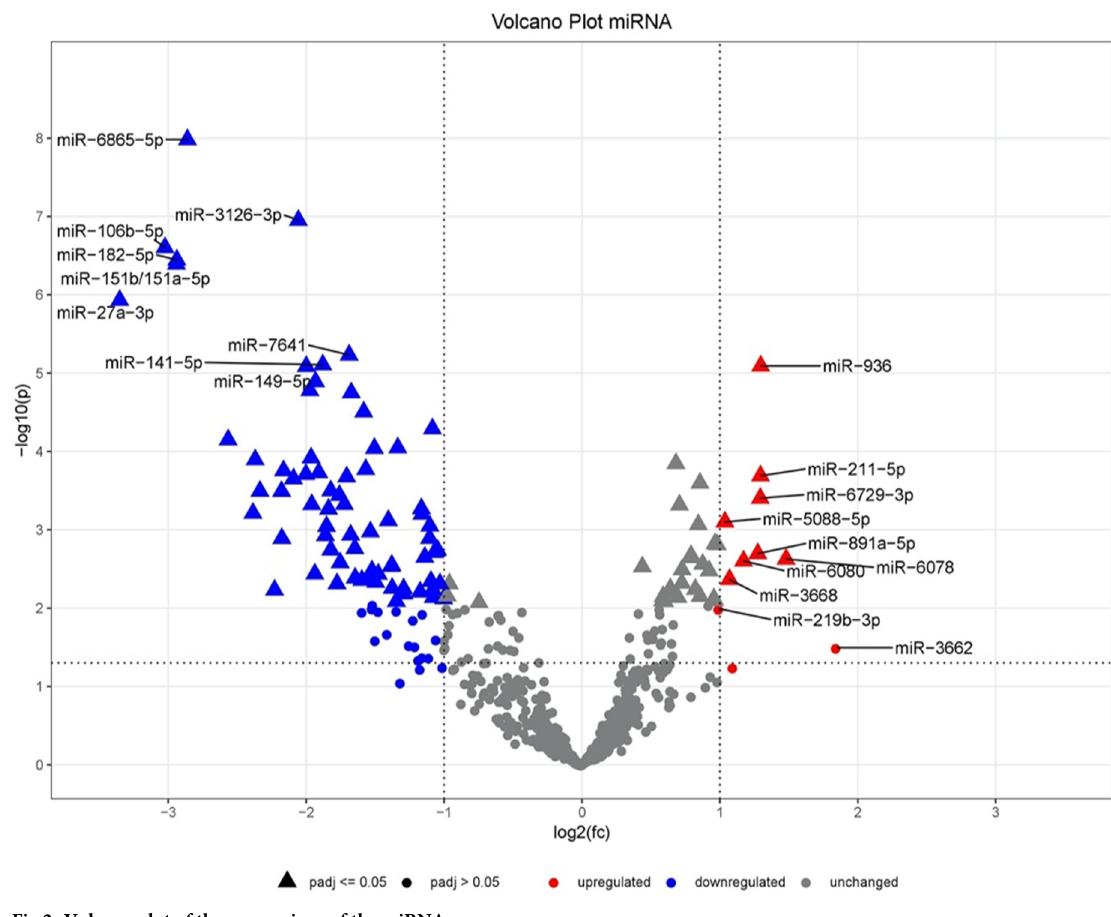
Fig 2. Volcano plot of the comparison of the miRNAs.